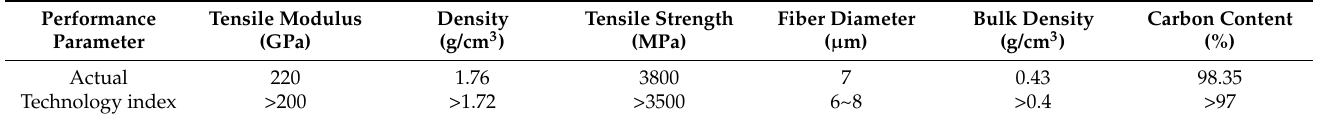
Table 8. Technical index of carbon fiber.